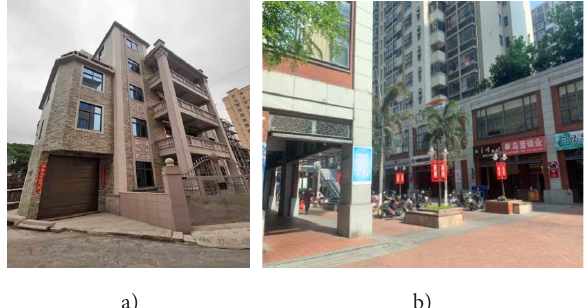
Figure 4. (a) Well-designed housing under index replacement model of Q village (left side); (b) Well-designed and well- planned facilities under the asset replacement model of G village (right